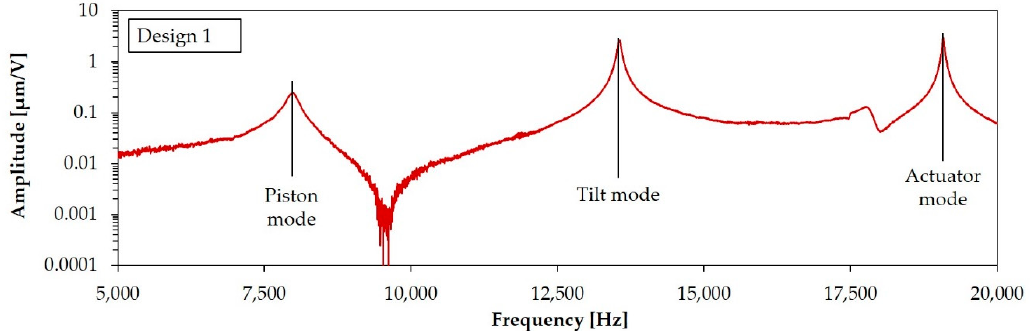
Figure 18. Frequency response curve of an individual sample of Design 1 (recorded at Point 1).